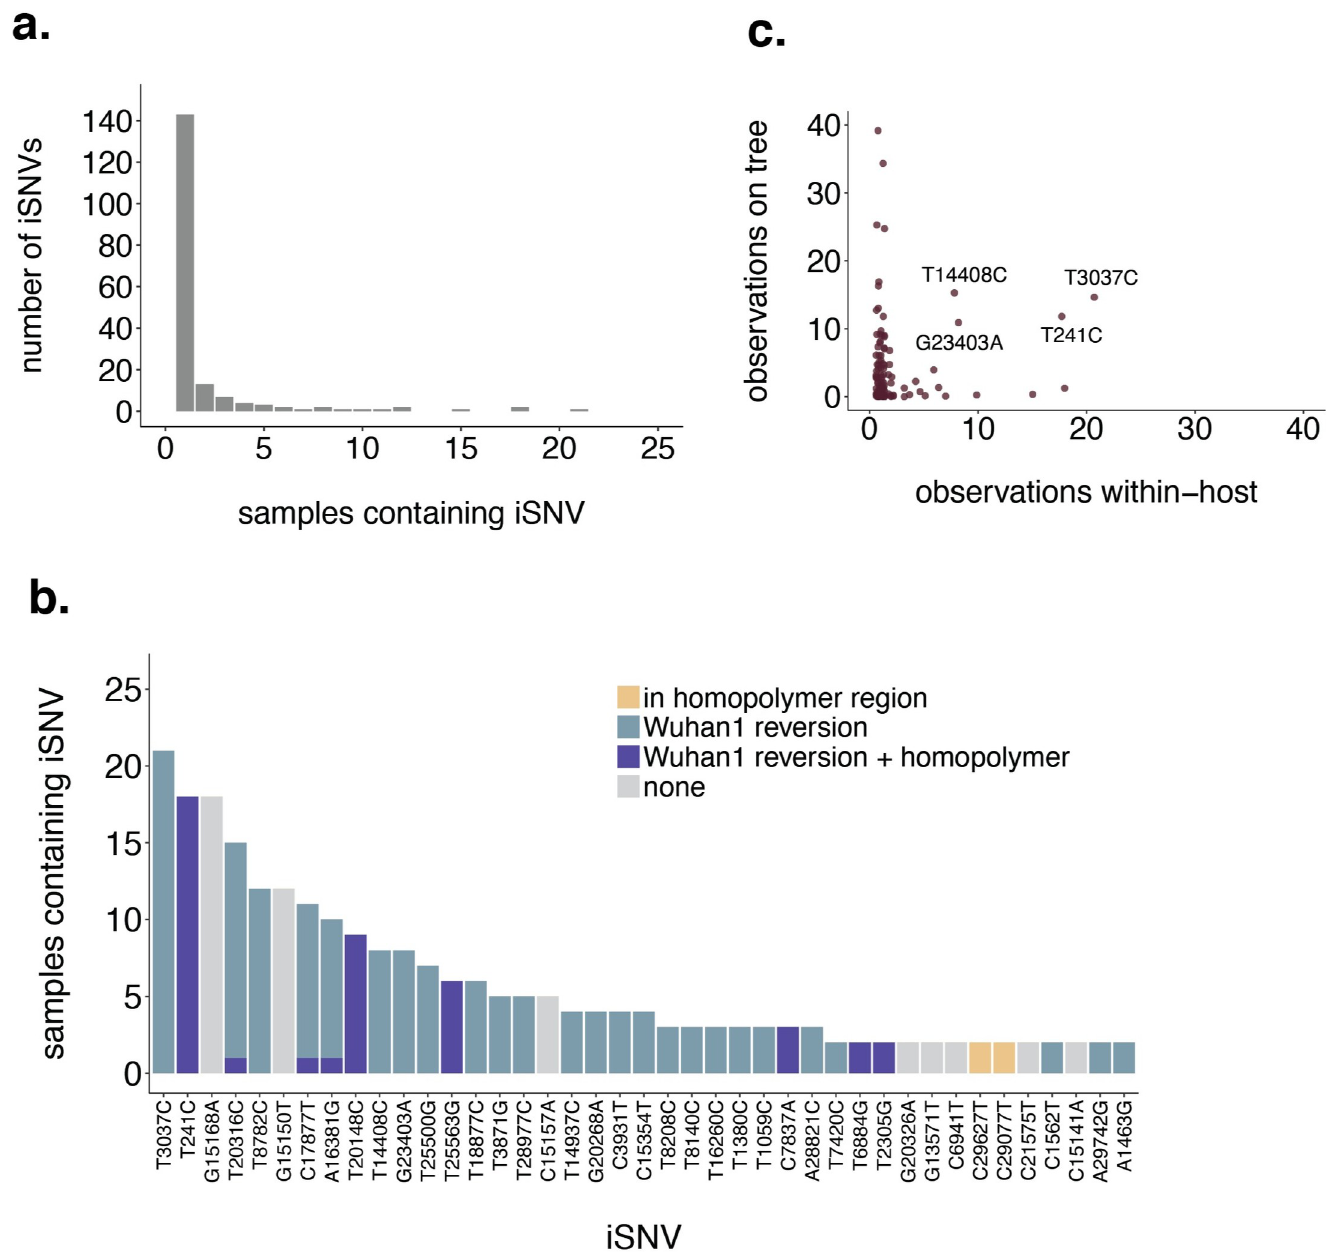
Fig 2. Shared iSNVs represent homopolymers and common polymorphic sites. a. The number of iSNVs (y-axis) present within n individuals (x-axis) is shown. 143/184 (77%) of iSNVs are found in only a single sample. 6 iSNVs are shared by at least 10 samples. b. Each iSNV detected in at least 2 samples is shown. Variants that occur within, or 1 nucleotide outside of, a homopolymer region (classified as a span of the same base that is at least 3 nucleotides long) are colored in yellow. Variants that represent the minor allele for variants that were nearly fixed at consensus (annotated here as “Wuhan1 reversions”) are shown in blue, and variants that were both Wuhan1 reversions and occurred in homopolymer regions are colored in purple. c. For each unique iSNV detected within a host, the x-axis represents the number of samples in which that iSNV was detected, and the y-axis represents the number of times it is present on the global SARS-CoV-2 phylogenetic tree. The counts on the phylogenetic tree represent the number of times the mutation arose along internal and external branches. The variants labeled with text are those that are detected at least 5 times within-host and at least 5 times on the phylogeny. Two of the most commonly detected iSNVs, T3037C and T241C (shown as the furthest to the left in panel b), are also frequently detected on the phylogenetic tree.